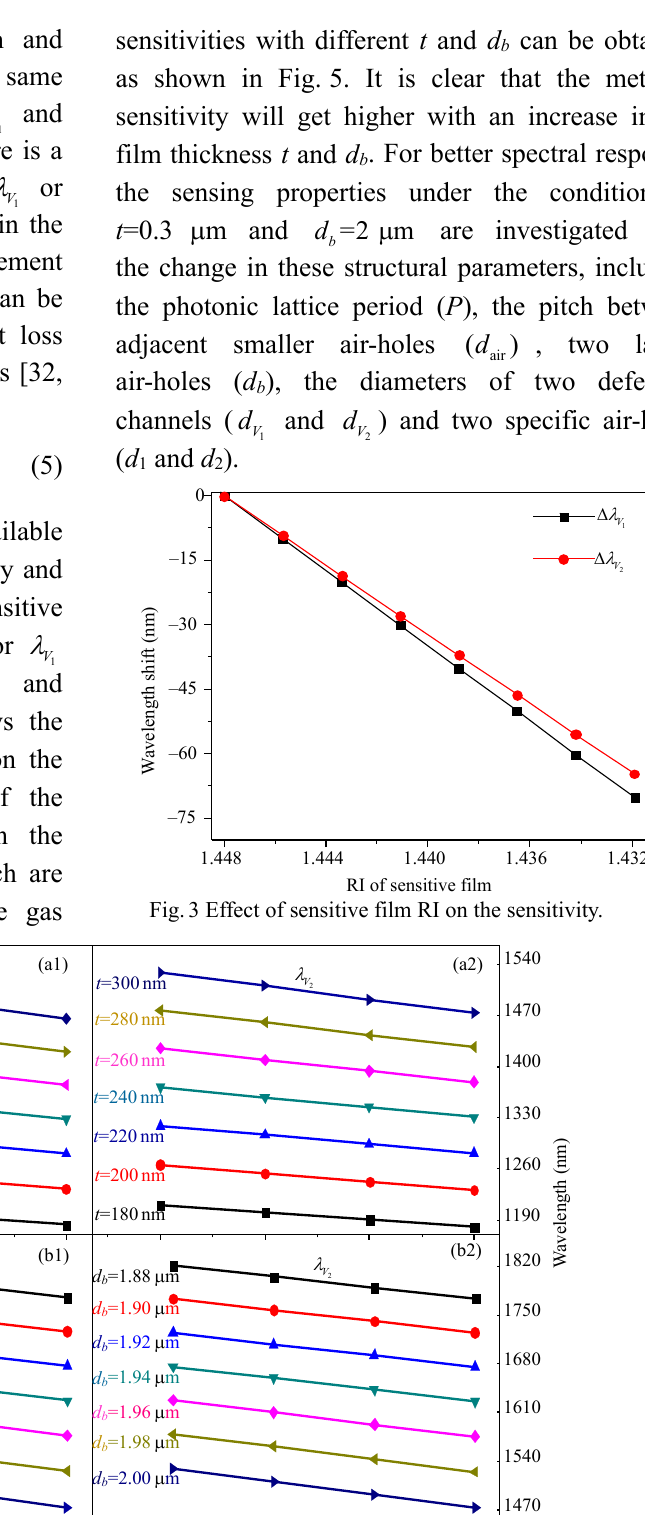
 at different t , (a2) 1 V